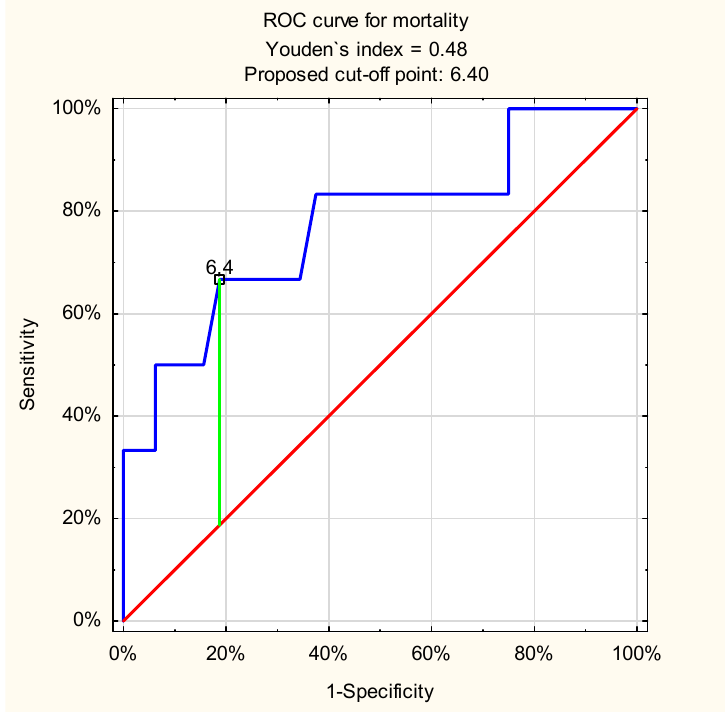
Figure 2. ROC curve for admission venous lactate level and in-hospital mortality in patients with variceal UGIB (proposed cut-off point = 6.4 mmol/L; sensitivity = 0.67; specificity = 0.81; accuracy = 0.79; AUC = 0.78 (95% CI: 0.55–1.0); p = 0.01).